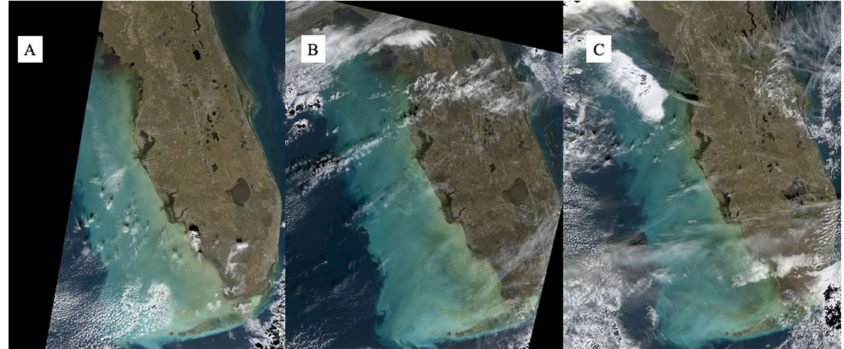
Figure 4. TC fields for the WFS from the OLCI sensor for ( A ) Sentinel 3B on 23 December, where the cloud cover has dissipated, however, the CAO event is still underway; ( B ) Sentinel 3B on 24 December; and ( C ) Sentinel 3B on 25 December, where the CAO event persists through 25 December (as shown in Figure 1). The satellite platform (Sentinel A or B) was selected based on the best spatial coverage for the WFS on that